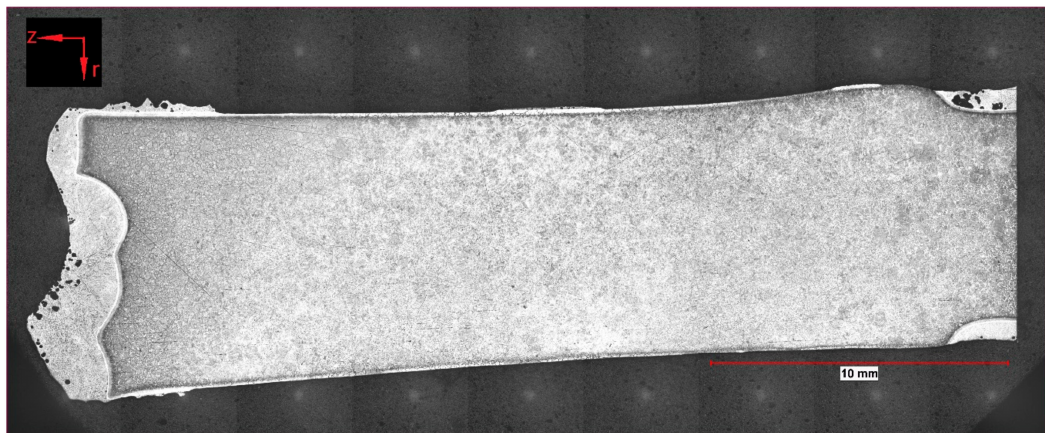
Figure 5. Nital-etched longitudinal area of stagnant sample number 107, submerged for 180 s into hot metal with an equilibrium temperature between scrap core and hot metal of 1300 ◦ C.